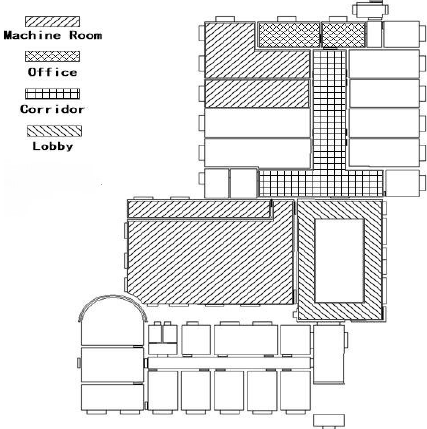
Figure 8. Distribution of the scene’s map for the generalization validation dataset.